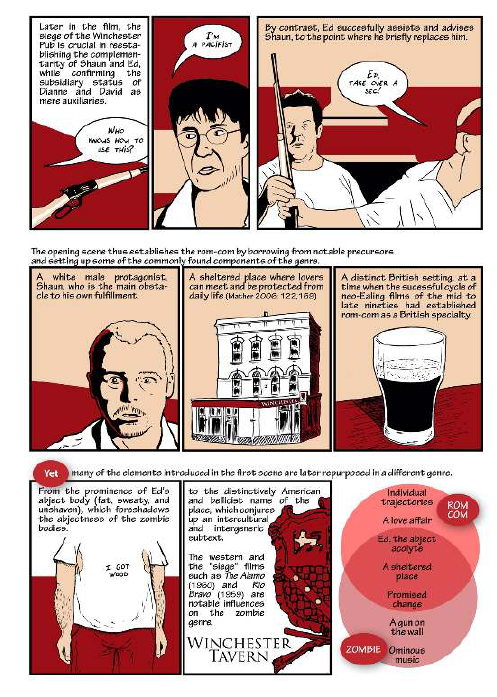
Credits: Jean-François Baillon and Nicolas Labarre.